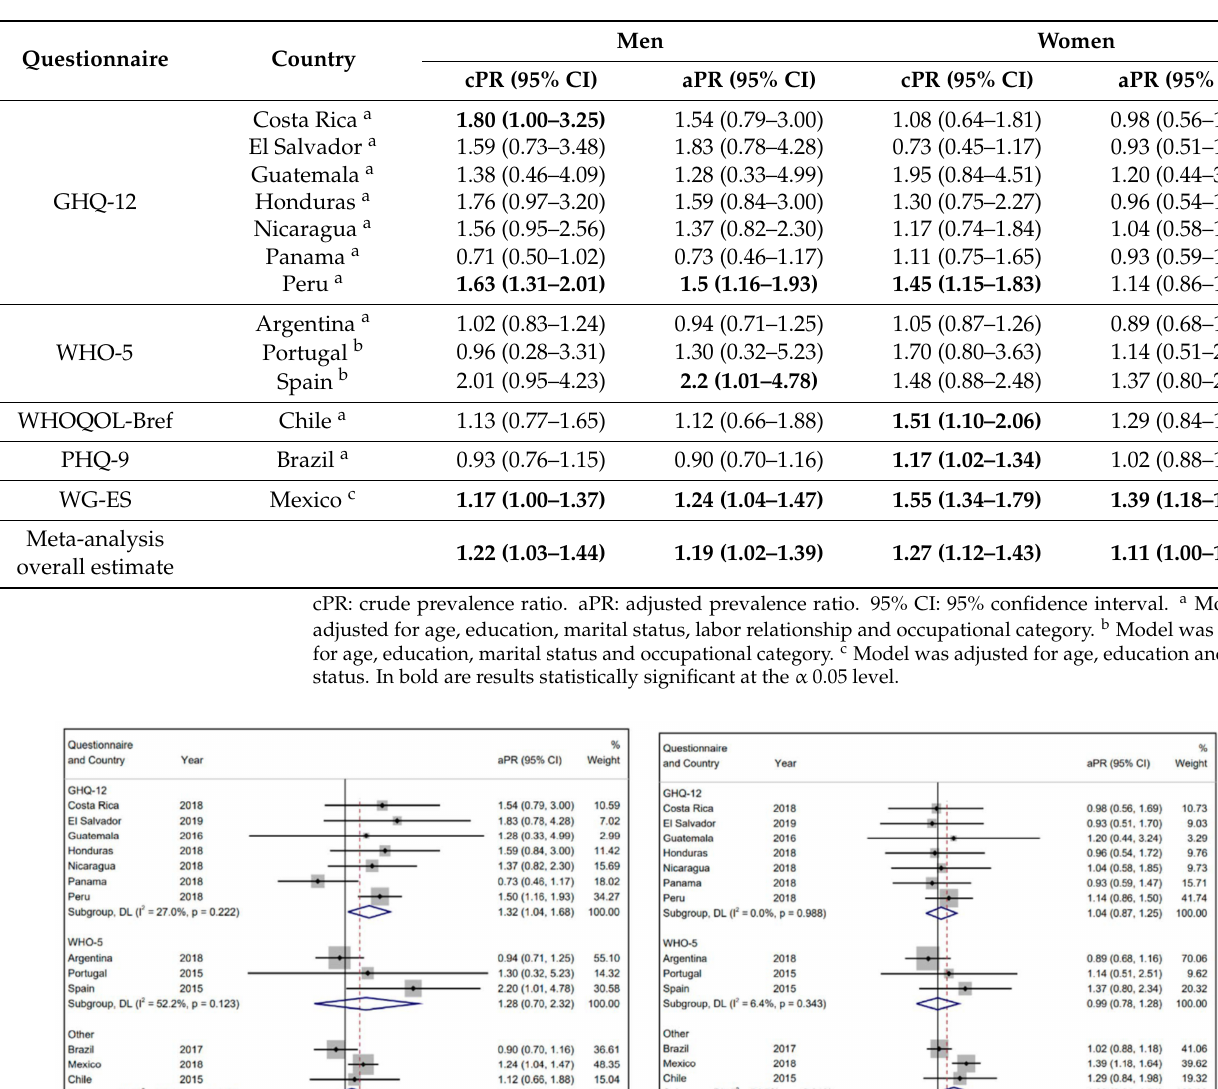
Table 3. Prevalence ratio of poor mental health between formal (Ref.) and informal workers by country and sex.